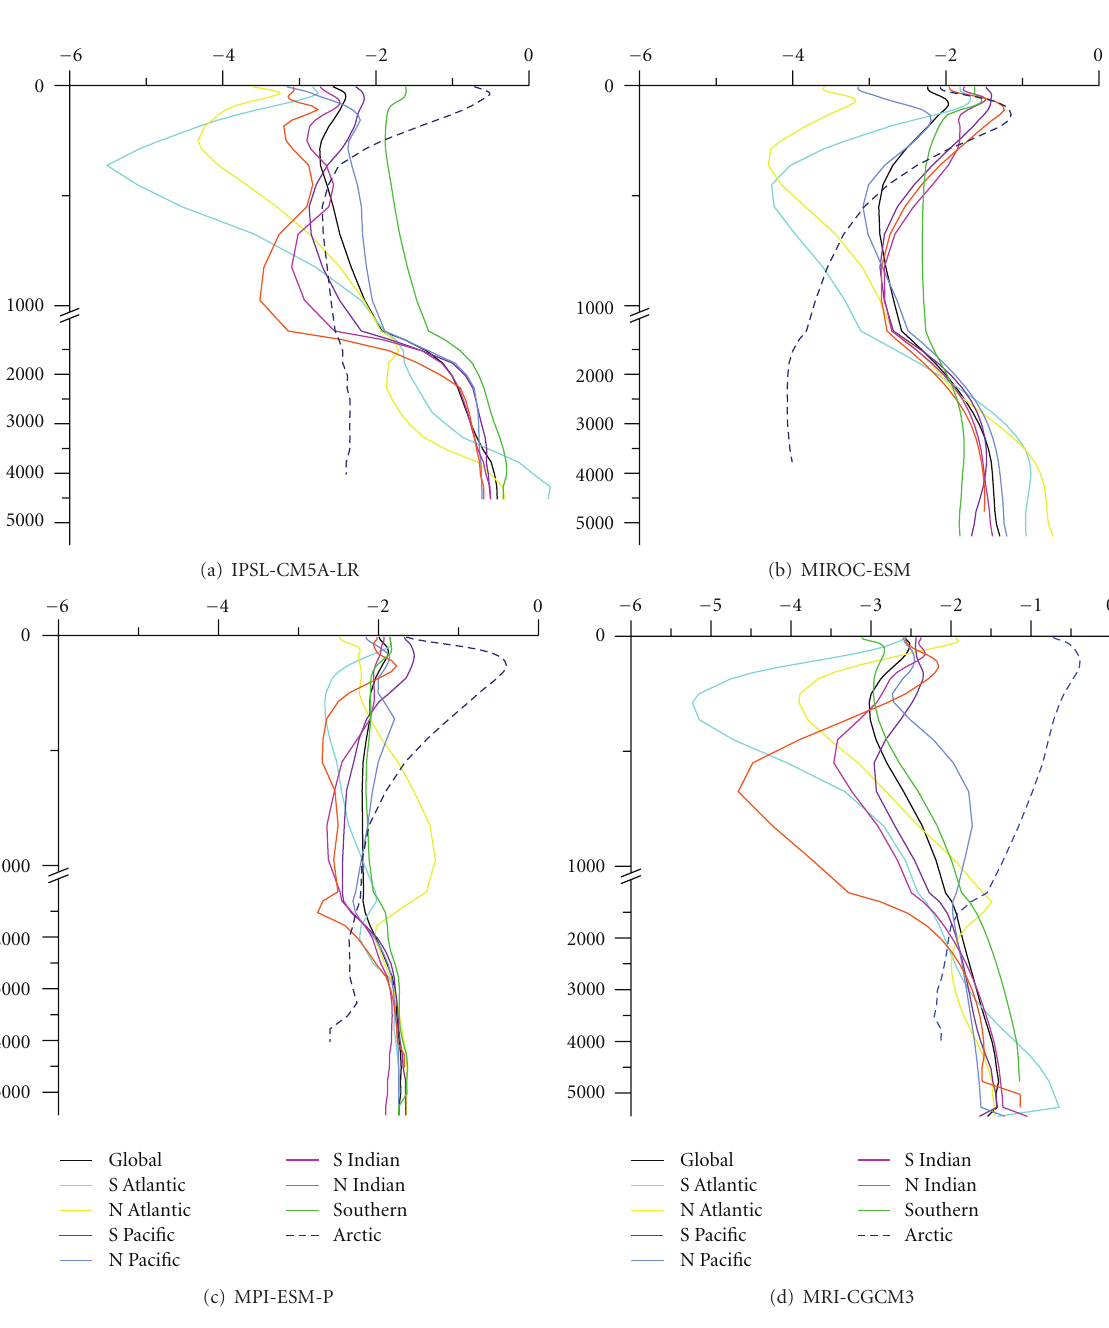
Figure 3: Ocean cooling profiles of global mean and ocean basins. The abscissa is temperature anomaly in ◦ C and the ordinate is water depth in m. The maximum surface warming occurs in the North Atlantic. Ocean cooling mostly concentrates in the upper 1000 m with rapid variations in di ff erent